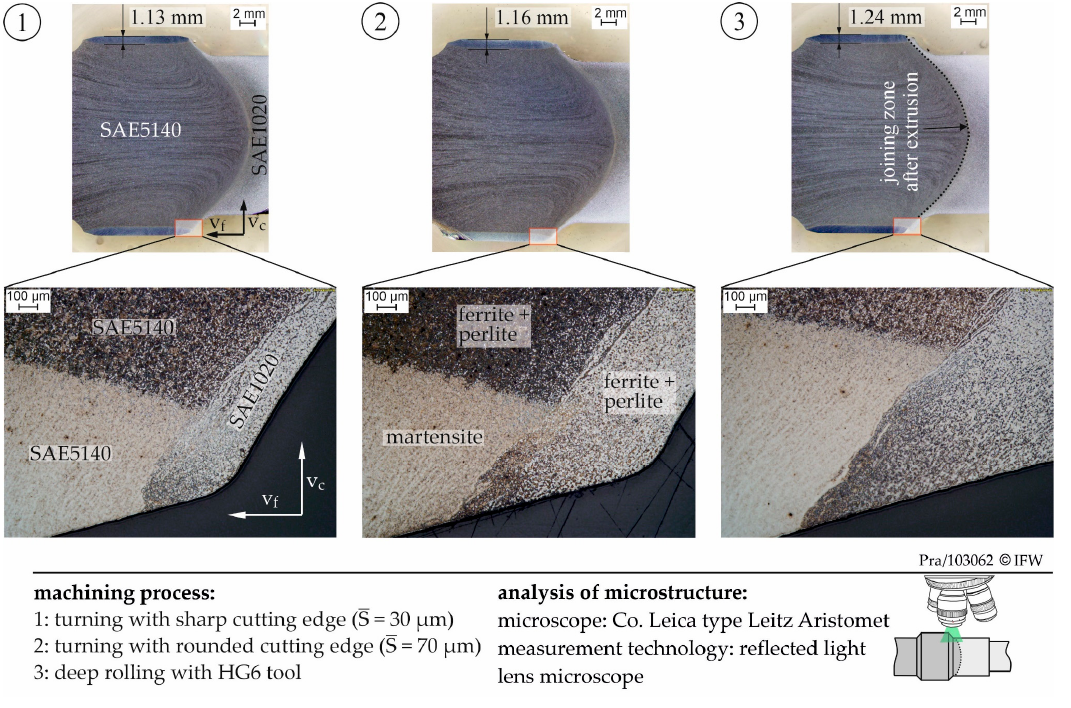
Figure 5. Influence of different manufacturing processes (1) turning with sharp cutting edge, (2) turning with rounded cutting edge and (3) deep rolling on the microstructure of hybrid components.